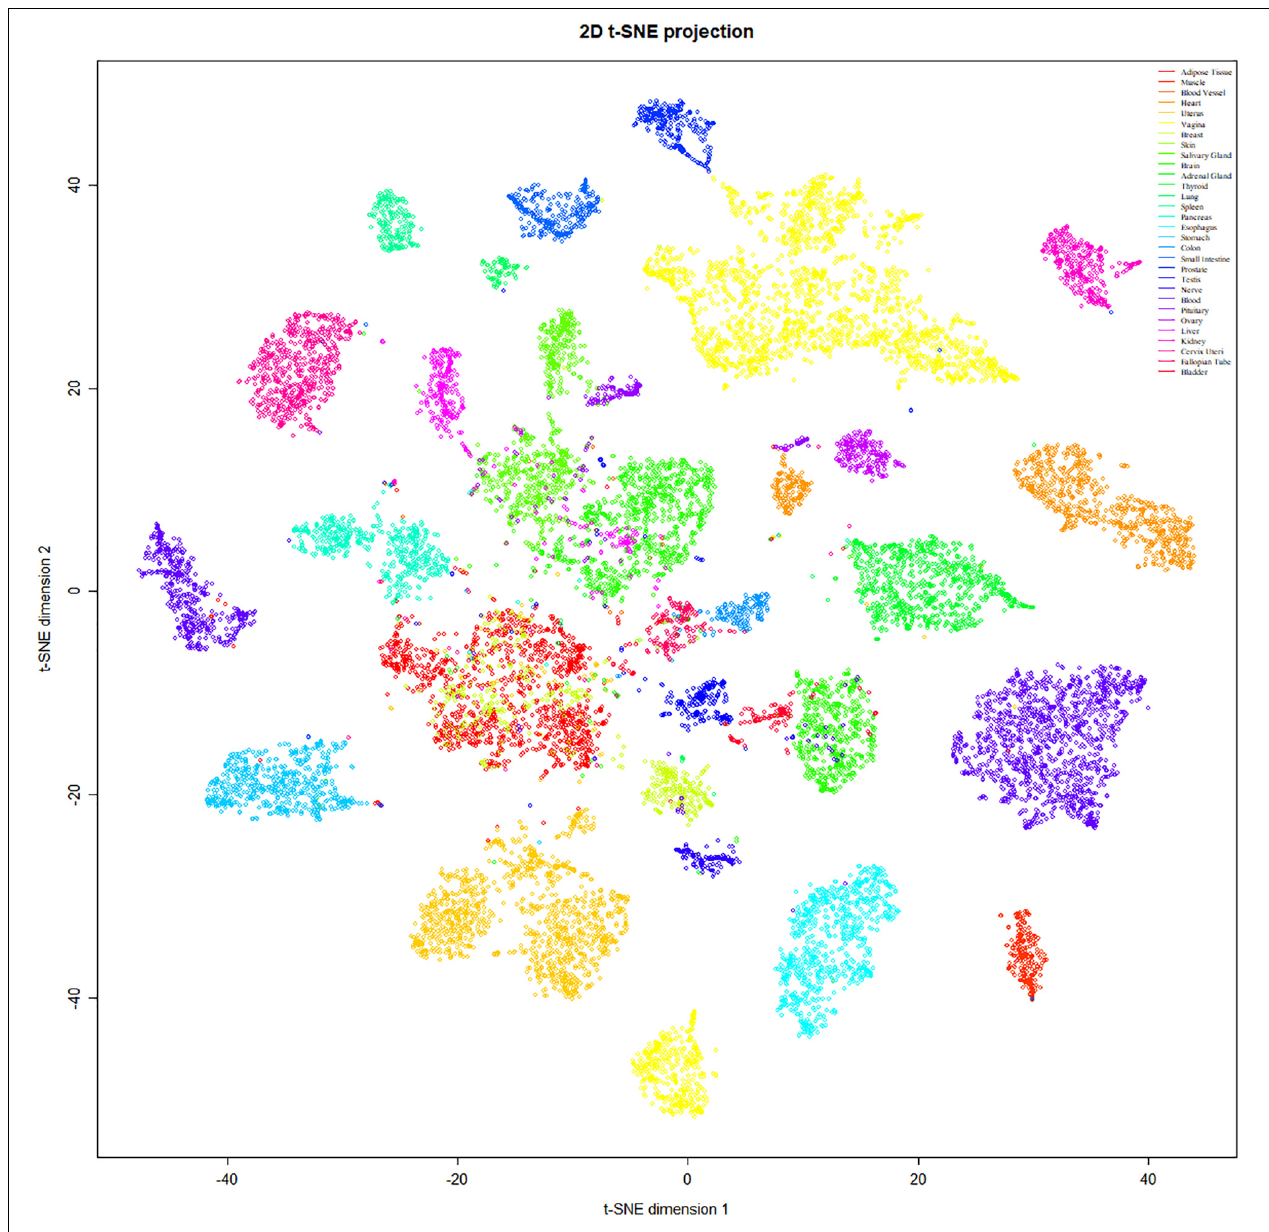
FIGURE 5 | Tissue specificity of the DEGs was identified in the discordant IBD twin pairs. The expression spectrum across 30 different tissue types indicates a variable spectrum of the identified